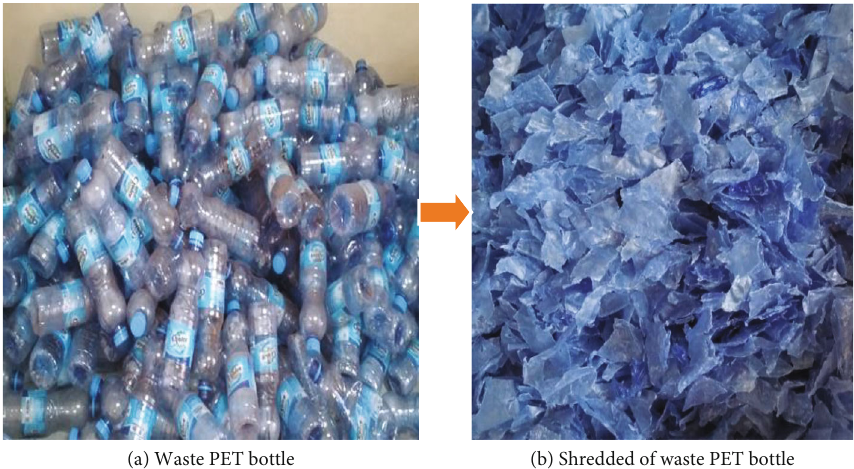
Figure 1: Shredding of PET